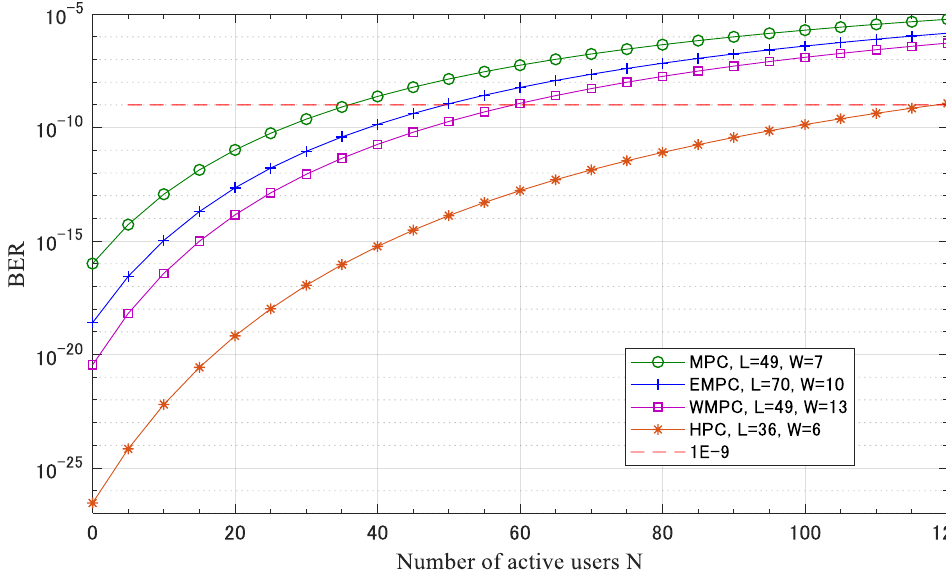
Figure 22. BER of OCDMA systems versus the number of active users N ( n = 3, L = 36 and W = 6).